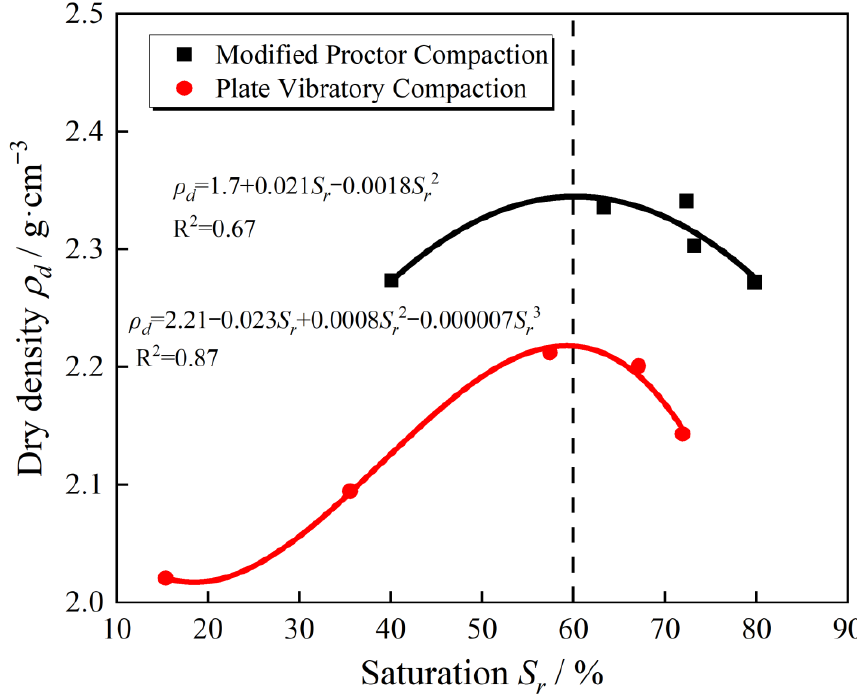
Figure 17. The curves of achieved dry density versus degree of saturation of UPAB specimens with a G/S value of 1.6 as generated from different laboratory compaction methods.